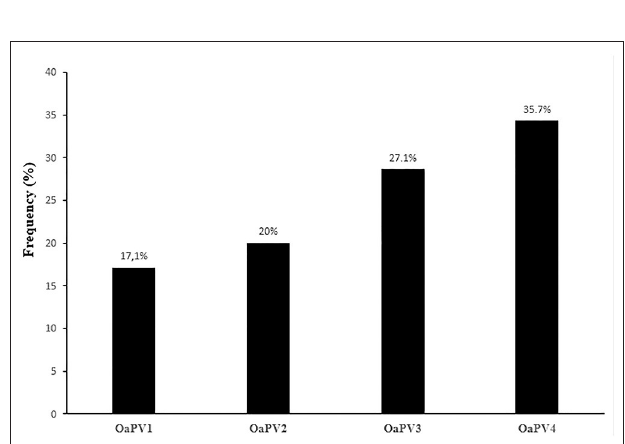
FIGURE 4 | Detection rates of single OaPV DNA found in 70 samples positive for a single infection.